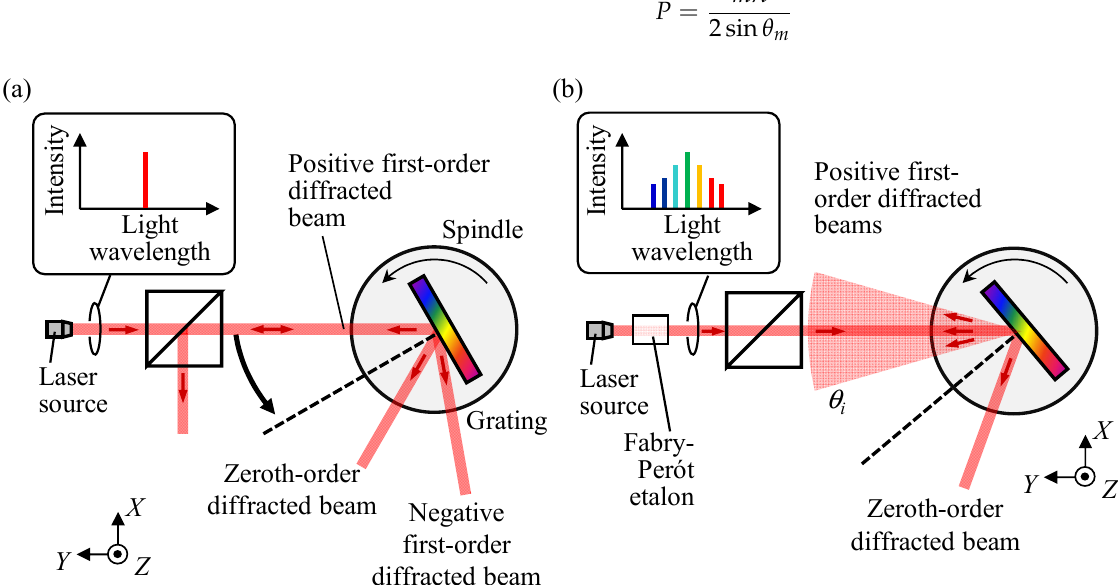
Figure 1. Laser diffraction method for measurement of a grating pitch: ( a ) Conventional method with a single-mode laser; ( b ) Proposed method with a mode-locked laser.